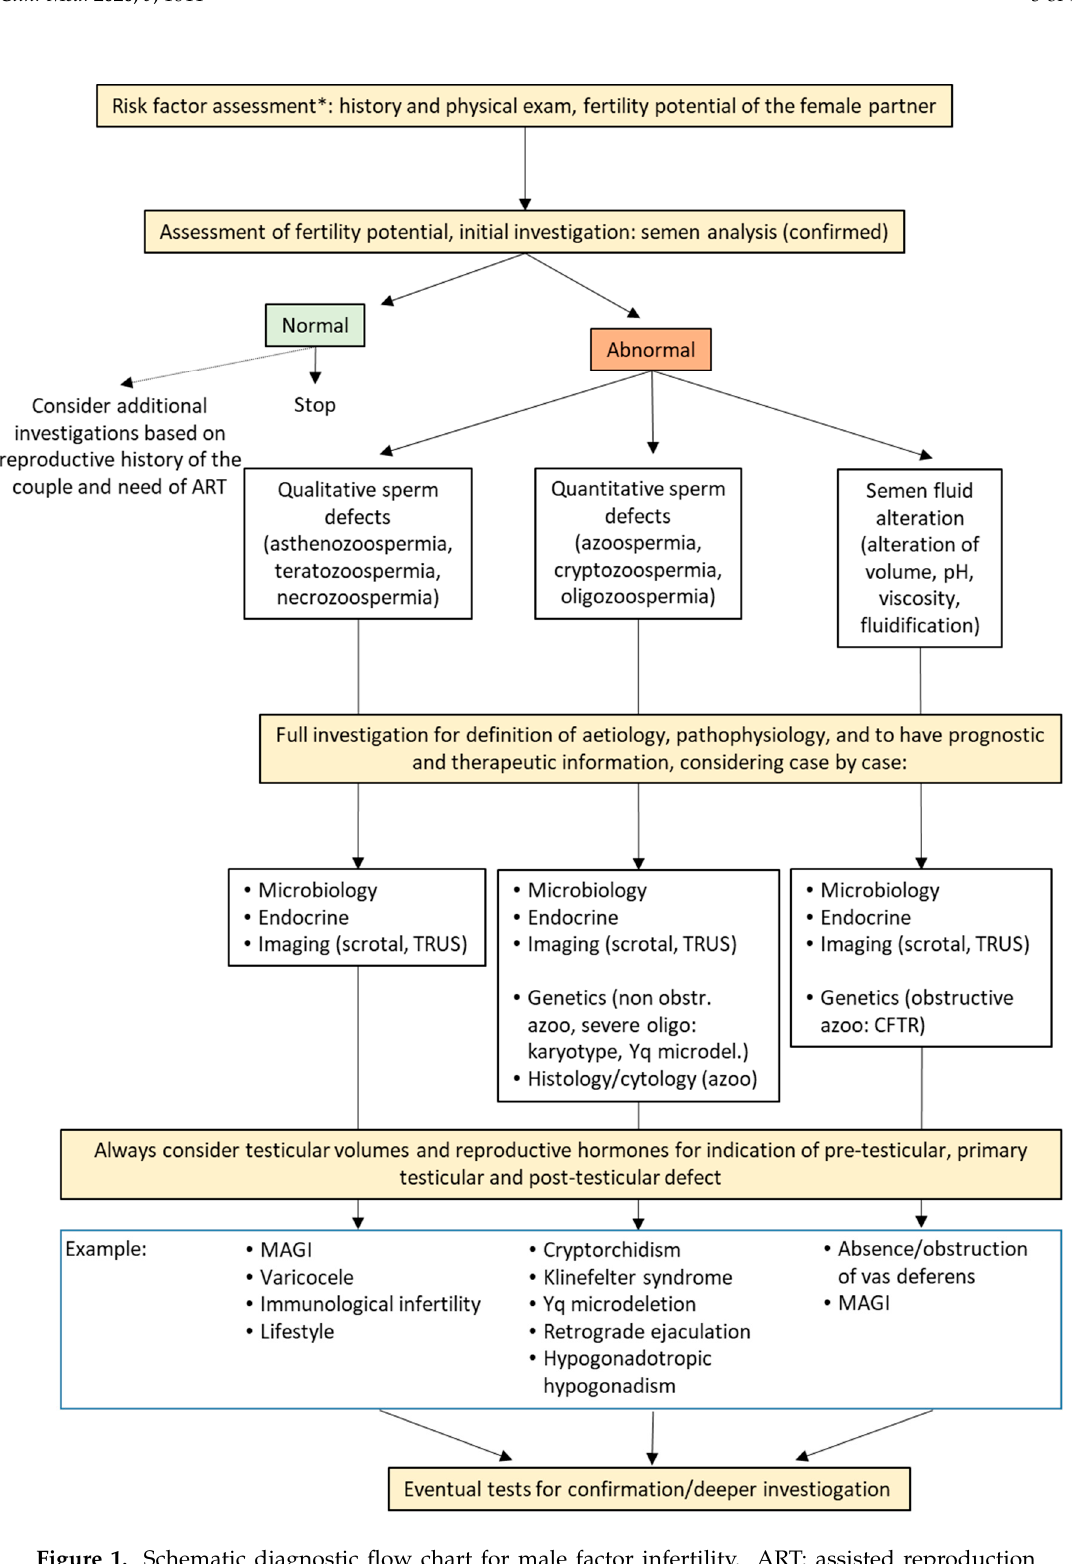
Figure 1. Schematic diagnostic flow chart for male factor infertility. ART: assisted reproduction technique; CFTR : cystic fibrosis transmembrane regulator; MAGI: male accessory gland inflammation; TRUS: transrectal ultrasound. * If risk factors are present, initial evaluation should already include full investigarion (microbiology, endocine, imaging, genetic), as appropriate.